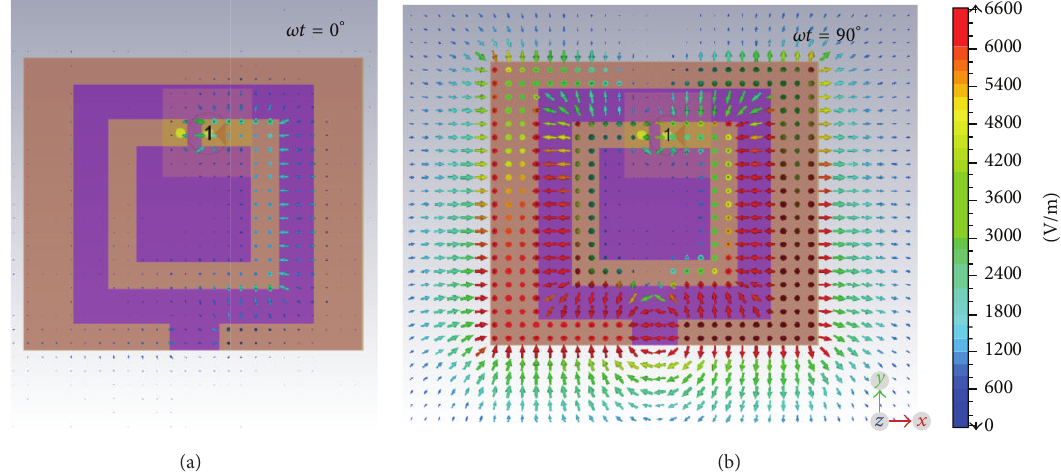
Figure 8: Electric field distributions of the antenna with ground plane in the 𝑥 - 𝑦 plane on the element surface at 920 MHz with (a) 𝜔𝑡 = 0 ∘